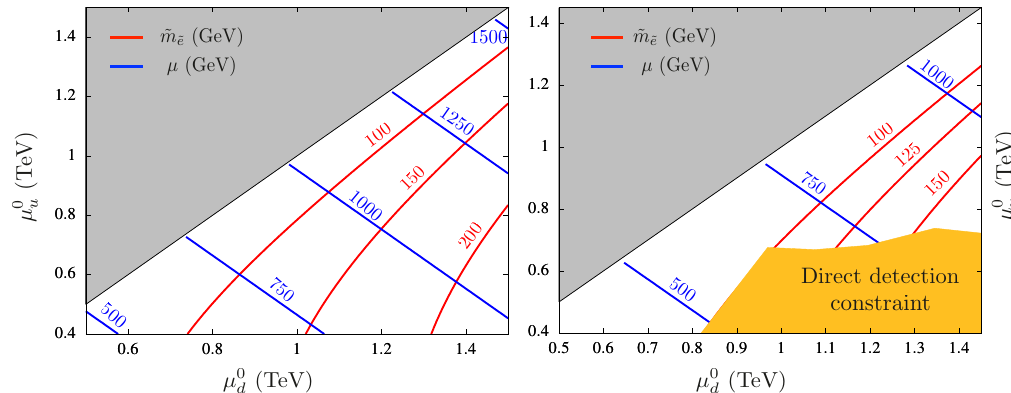
Figure 9 . We show the contours of right handed slepton mass (red) and higgsino mass (blue) in the (cid:22) 0 - (cid:22) 0 plane. To obtain positive de(cid:12)nite mass for the right handed sleptons one needs to have u d (cid:22) 0 > (cid:22) 0 , therefore, ruling out the shaded region. For de(cid:12)nite values of right handed slepton and u d higgsino masses, designated by the crossing of the contours, the two input parameters (cid:22) 0 and (cid:22) 0 u d can be readily obtained. We have (cid:12)xed (cid:3) int = 10 11 GeV and tan (cid:12) = 2 : 5. We have (cid:12)xed (cid:21) S = 0, for the (cid:12)gure in the left panel. In such a scenario, the direct detection constraints are not relevant. However, for the (cid:12)gure in the right panel, we have (cid:12)xed (cid:21) S = 0 : 8 and show the excluded region after taking into account constraints from direct detection experiments . shaded region in the right panel plot of (cid:12)gure 9 shows the excluded parameter space when direct detection results (LUX WS 2014-16) [97] are taken into consideration. We reiterate that the LEP results exclude parameter space where slepton masses are below 100